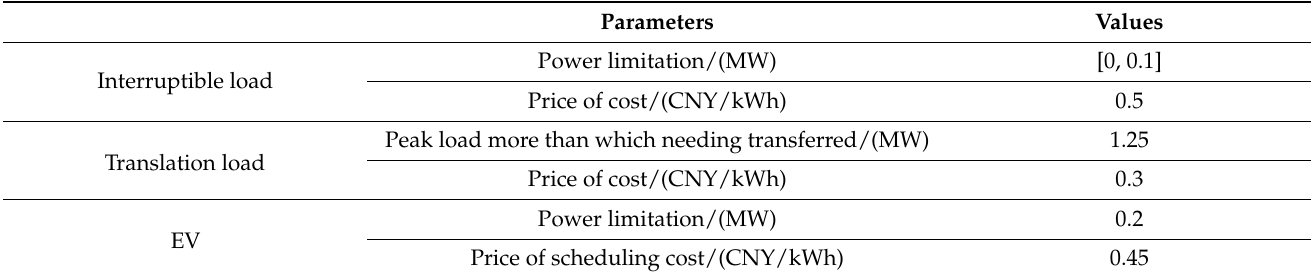
Table 5. The parameters of the interruptible load, translation load and